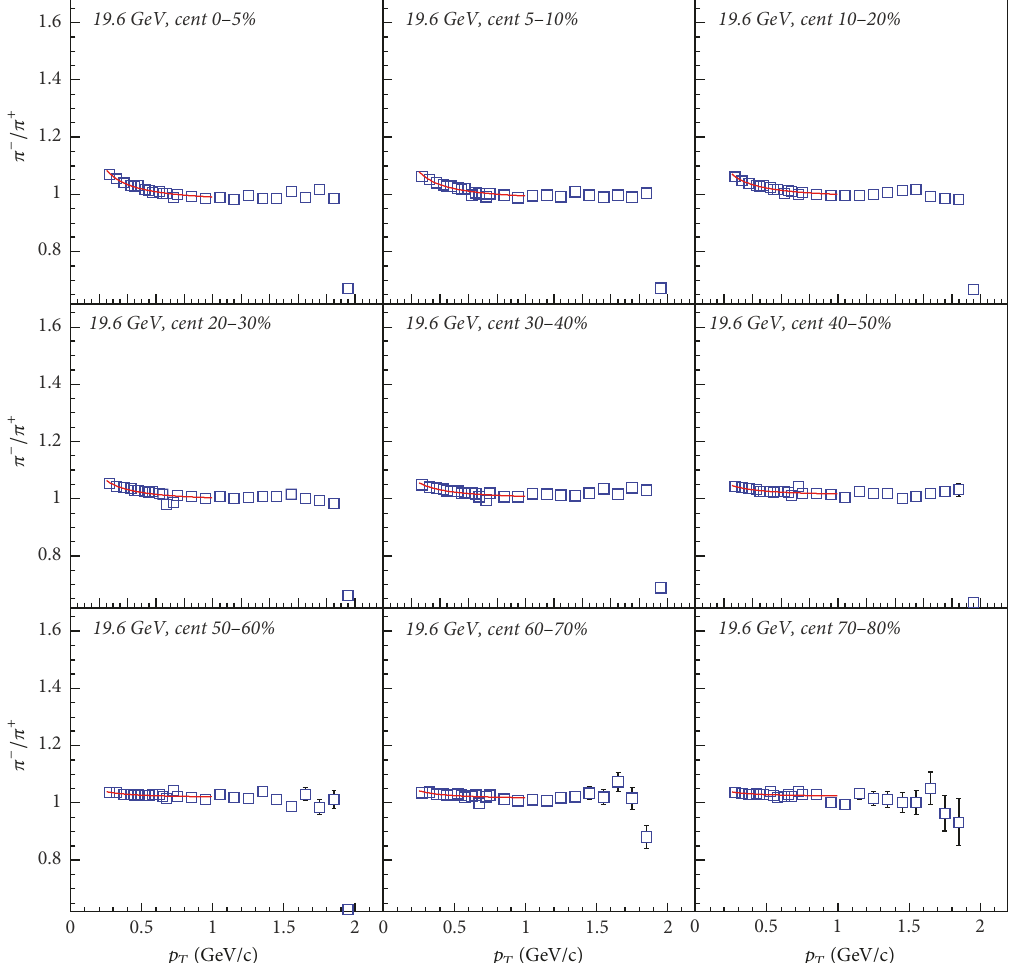
Figure 3: The 𝜋 − /𝜋 + ratios produced in Au+Au collisions at 19.6 GeV as a function of transverse momentum. The data are from [14]. The red lines are the fits to the ratio data using (2).